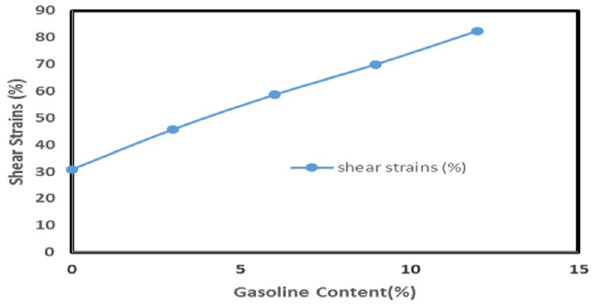
Fig. 24 Shear strain changes for soil with different contamination amounts